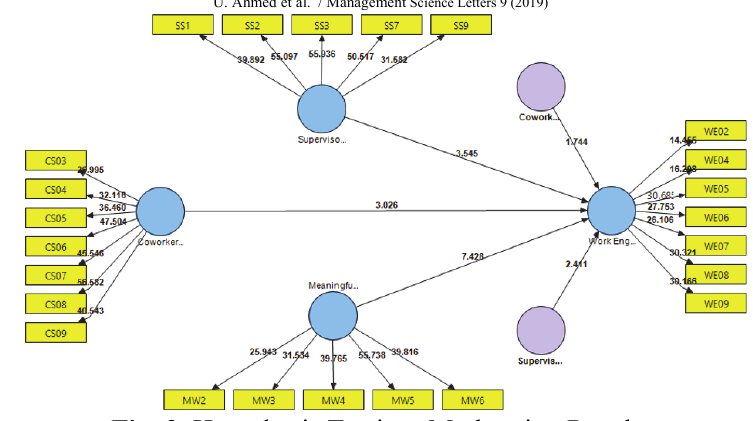
Fig. 3. Hypothesis Testing- Moderation